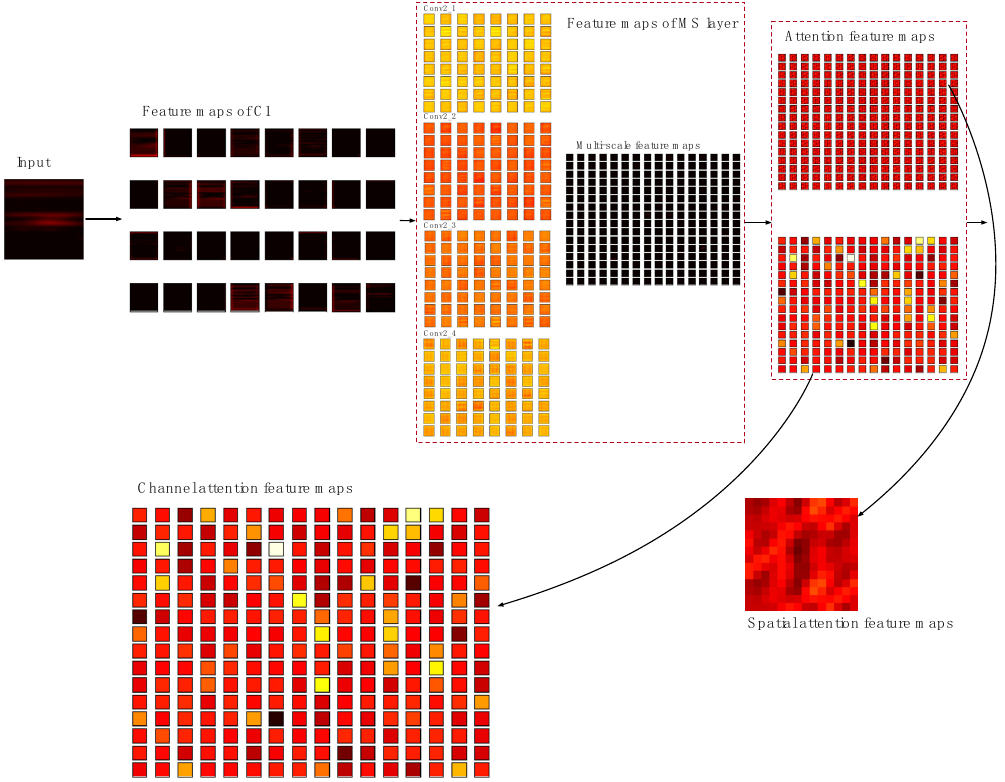
Figure 8. Feature maps of flow in the MA-MSCNN structure. The colors in the attention feature map represent the weights of attention.